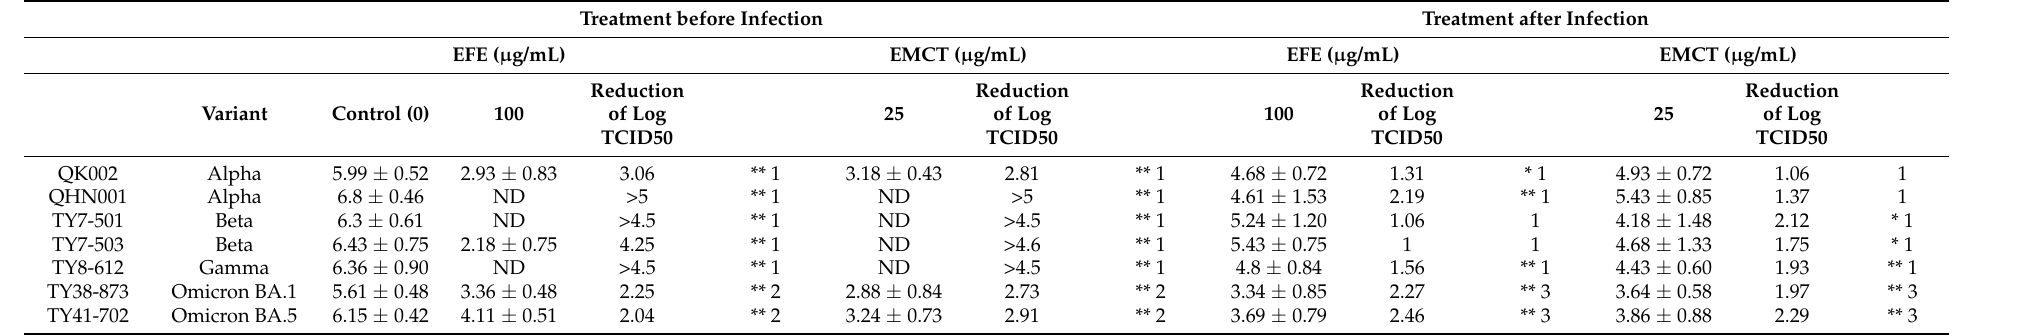
Table 3. Reducation of log10TCID50 of variant strains within culture supernatant at 24 h post infection. Treatment before Infection Treatment after Infection EFE ( µ g/mL) EMCT ( µ g/mL) EFE ( µ g/mL) EMCT ( µ